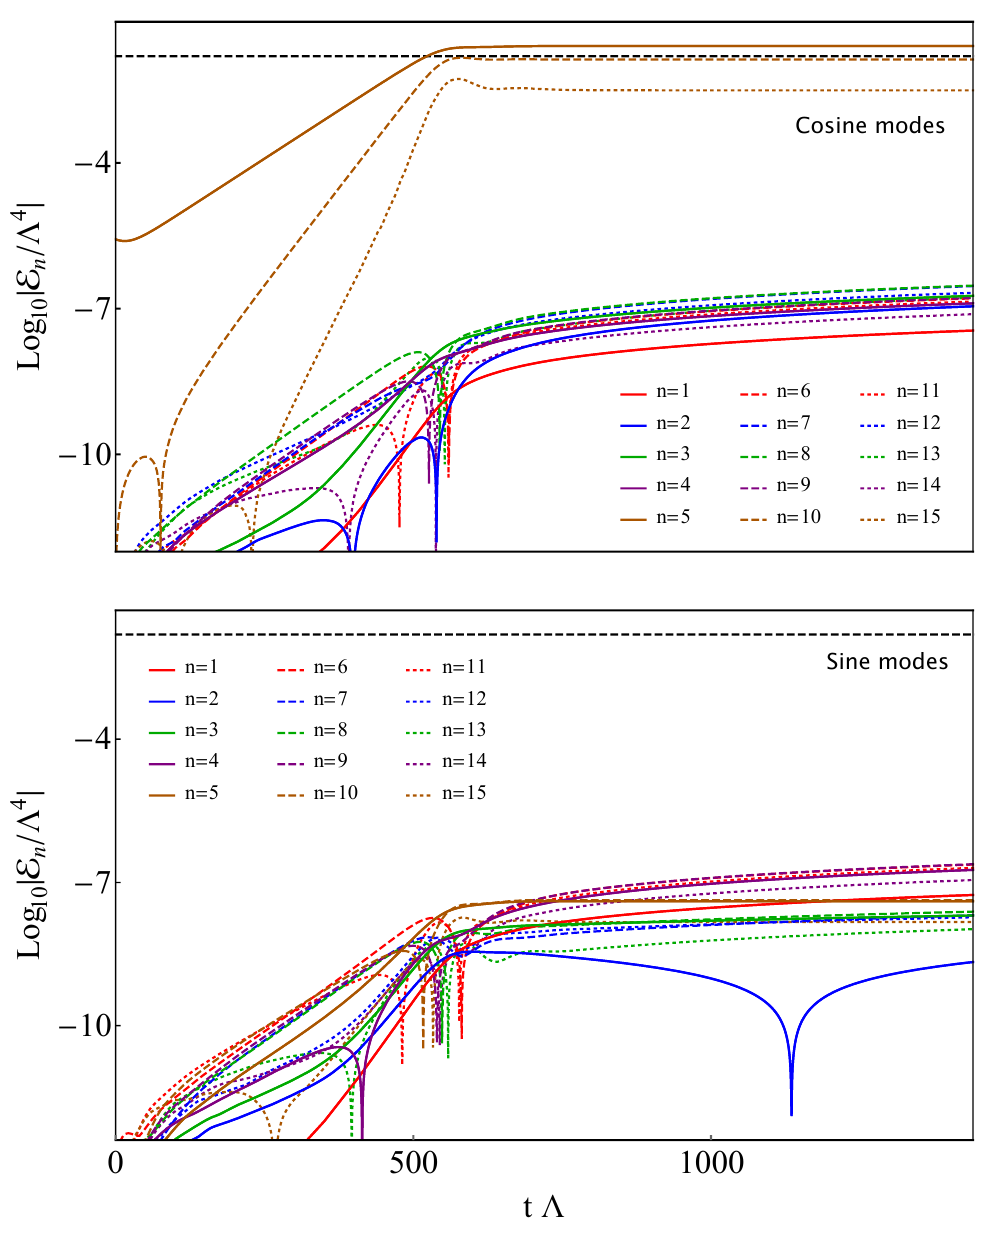
Figure 21 . Late time evolution of some Fourier modes of the energy density shown in (cid:12)gure 16(left). The black, dashed horizontal lines at the top indicate the average energy density or, equivalently, the n = 0, constant mode.